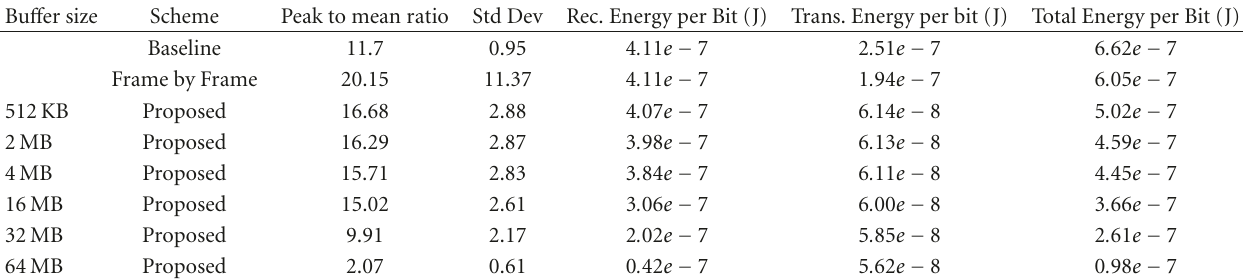
Table 6: Performance comparison for di ff erent bu ff er sizes for Stream 3 ( d = 15 m).